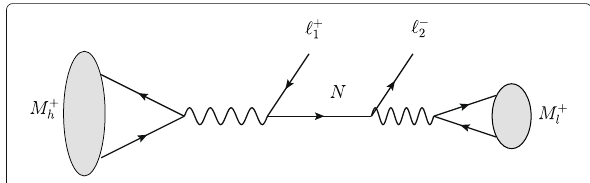
Fig. 1 The semileptonic decay of charged heavy mesons, in which ( M + ) means a charged heavy (light) M + h l